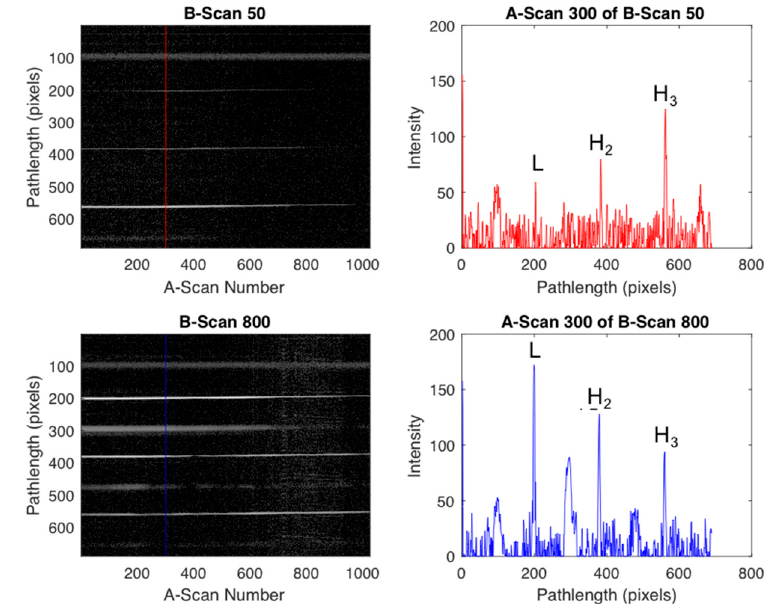
Figure 11. Sample B-scans show how the intensity of Pathlengths 1–3 vary for different angles. At A-scan 300 of B-scan 50, Pathlength 3 (H 3 ) has the strongest intensity. This indicates that the mirror was at an extreme angle. In contrast, for A-scan 300 of B-scan 800, Pathlength 1 (L) has the strongest signal; this indicates that the mirror was at an angle closer to zero (direct back-scatter). A-scan numbers represent a linear increase in bulk scattering angle in one dimension, and B-scan numbers represent a linear increase in bulk scattering angle in the other dimension. See Figure 12A for the transformation from A-scan/B-scan number to angle.